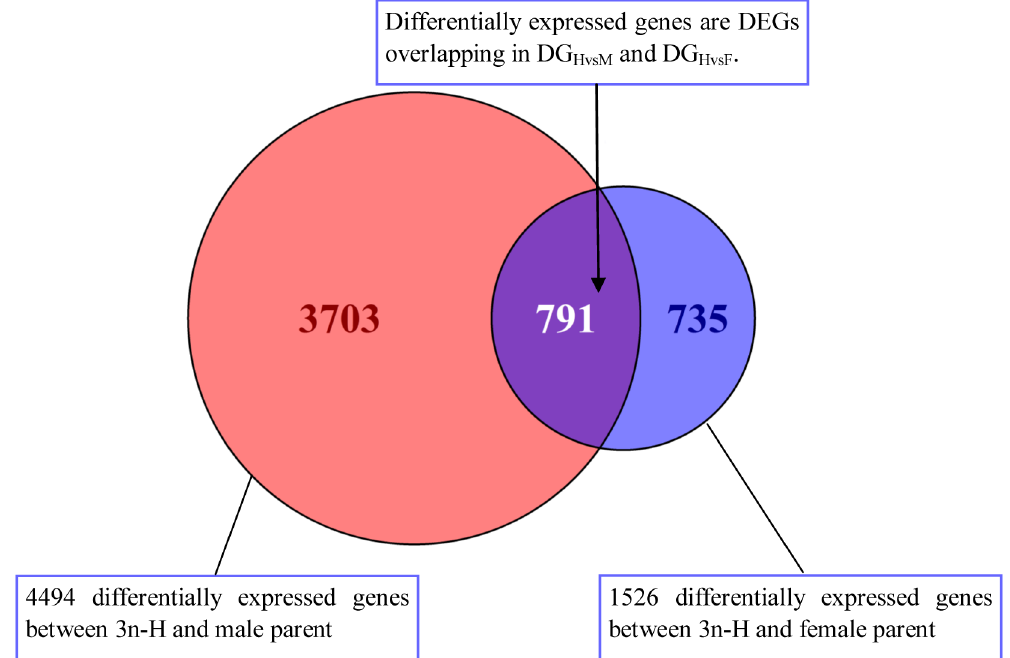
Figure 3. Venn diagrams of genes that are differentially expressed in diploid parents and high-growth allotriploid Populus progeny (PMR-H, indicated as 3n-H in figure). DG HvsM and DG HvsF refer to DEGs from the PMR-H vs. male parent, the PMR-H vs. female parent, respectively. We found 791 genes were common to both groups (DG HvsM and DG HvsF ). The largest numbers of genes (320, 40.5%) were up-regulated in the PMR-H compared to the parents (Table S2), while 275 (34.8%) genes were down-regulated (Table S3). In addition, 49 (6.2%) genes were up-regulated compared to male parent and down-regulated compared to female parent (Table S4), and 89 (11.3%) genes were up-regulated compared to female parent and down-regulated compared to male parent ( p- values < 0.05) (Table